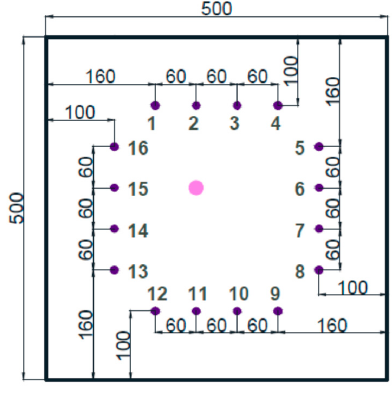
Figure 6. The layout of the PZT sensors. (The unit in the figure is mm.)